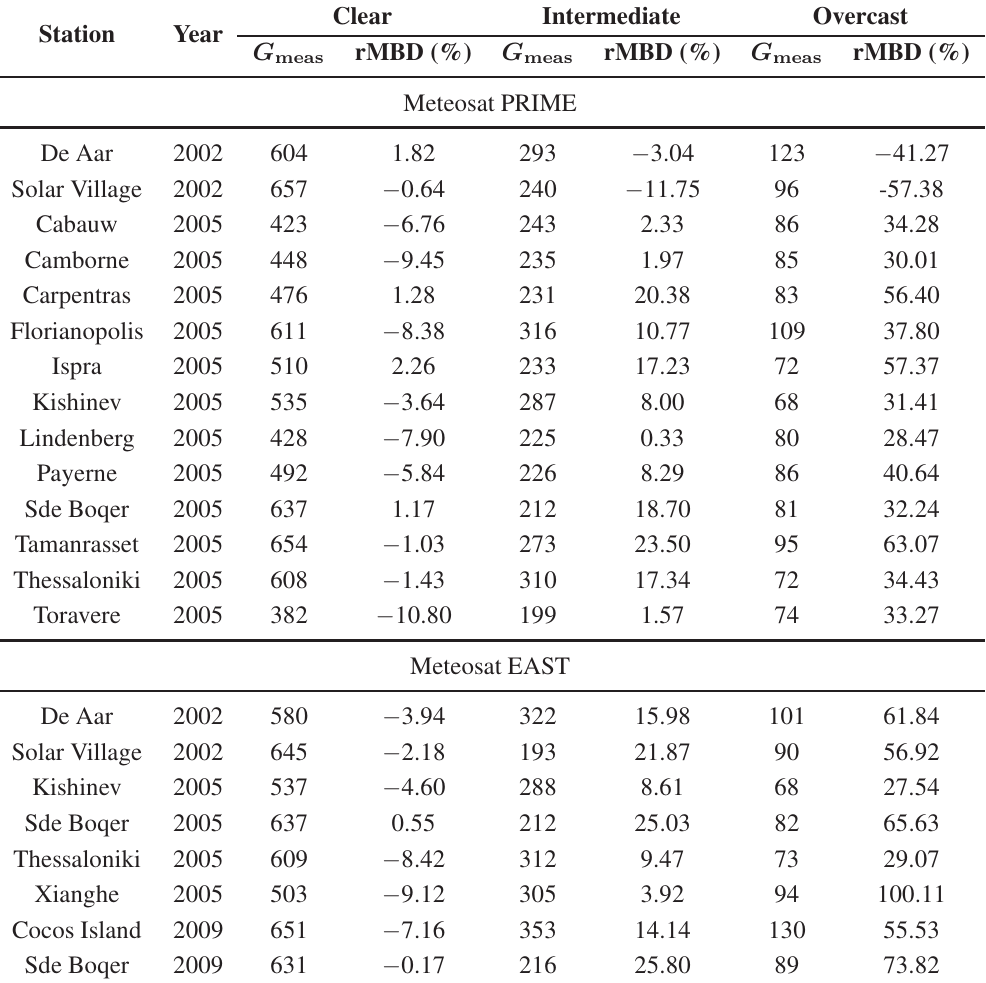
Table 4. Relative mean bias deviation of the global horizontal irradiance retrieval, according to sky type. In this table the average irradiance values (given in Wm − 2 ) are calculated considering only daytime